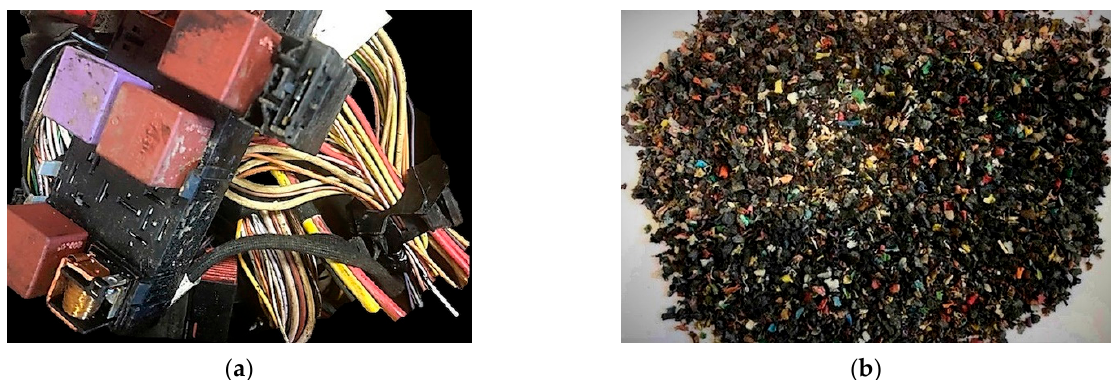
Figure 1. Origin wastes: ( a ) automotive originated cables wastes; ( b ) recovered and separated polymeric wastes of 1.8 mm fraction.